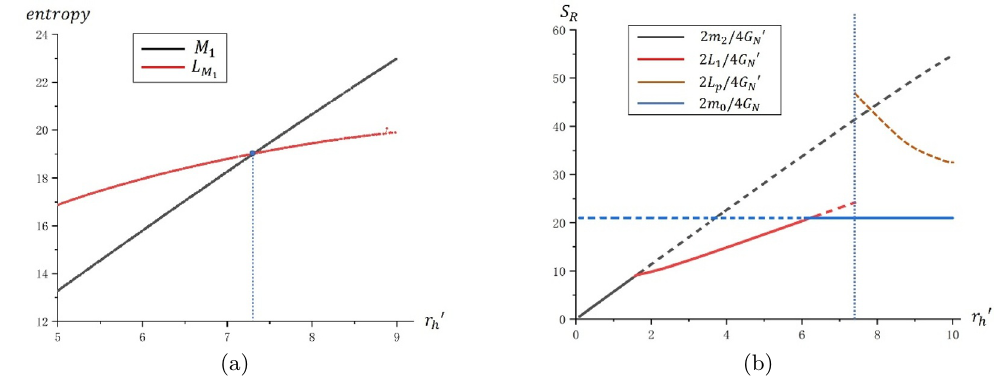
. The RT surface of M 1 is one of the two 1 when r 0 > 7 . 3 . (b)We h 1